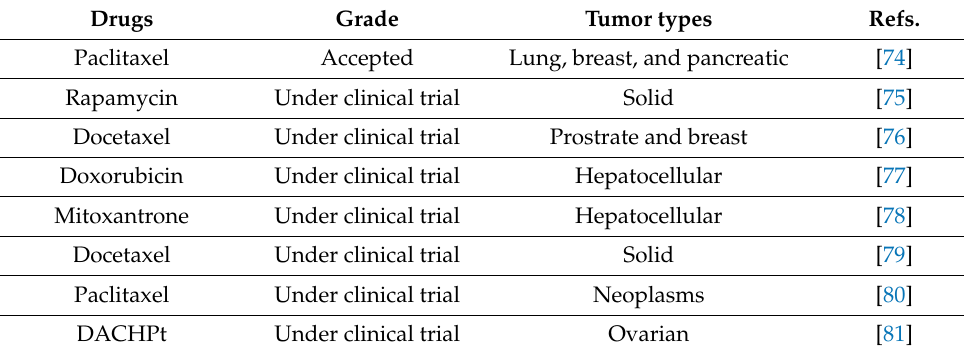
Table 3. The polymer colloids-based anti-cancer drugs in clinical trials. Drugs Grade Tumor